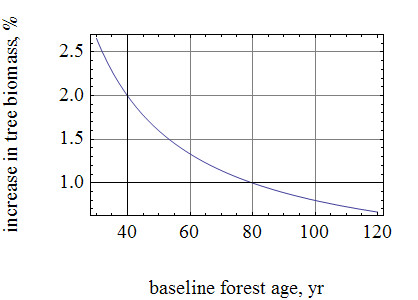
The conservative estimate of the relative increase in tree biomass (δ B) induced by one-year delay (ΔA = 1) in harvesting.